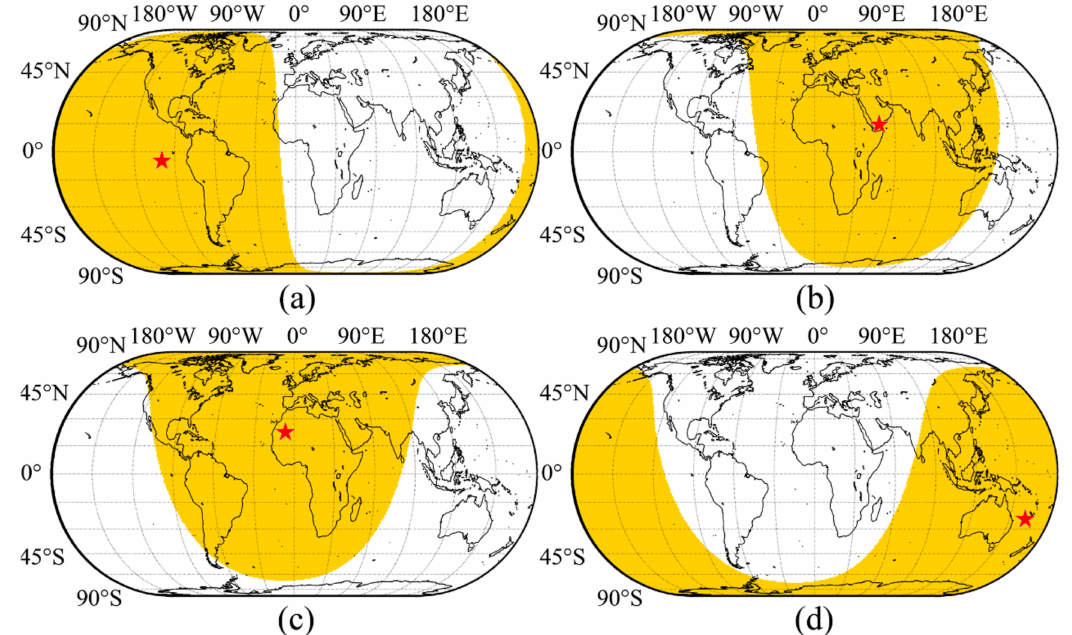
Figure 3. Observational scope of a Moon-based sensor when the Moon is at ( a ) perigee, ( b ) apogee, ( c ) maximum inclination above the Earth equator plane, and ( d ) maximum inclination below the Earth equator plane. The red dot is the nadir point of the Moon-based platform, which is the center of the observational